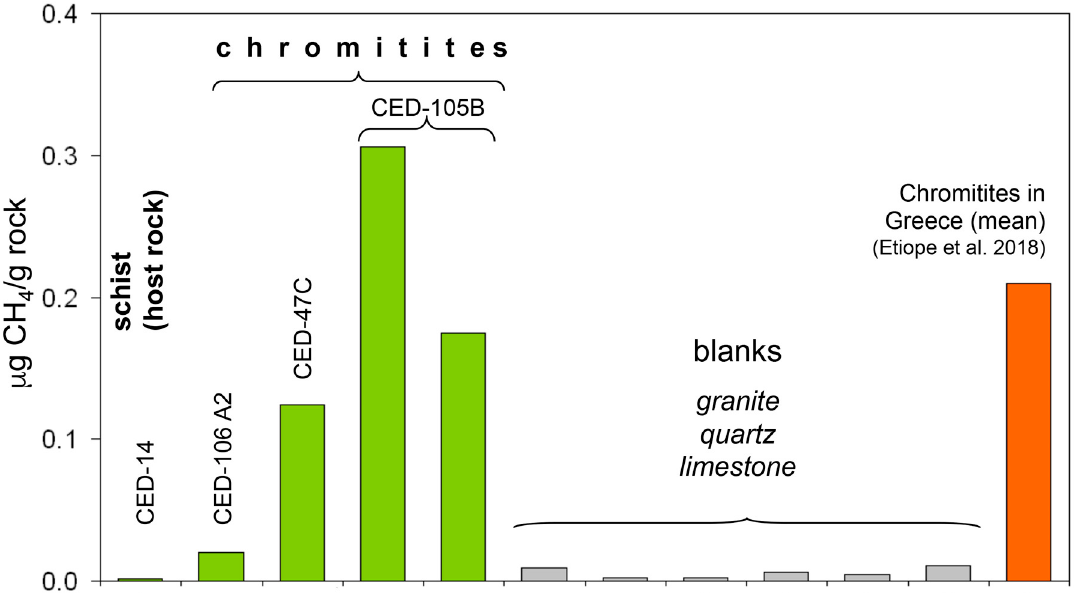
Figure 6. Methane content in the Cedrolina (CED) samples compared with blank rock samples and the average CH 4 content in chromitites of greek ophiolites reported by [22].